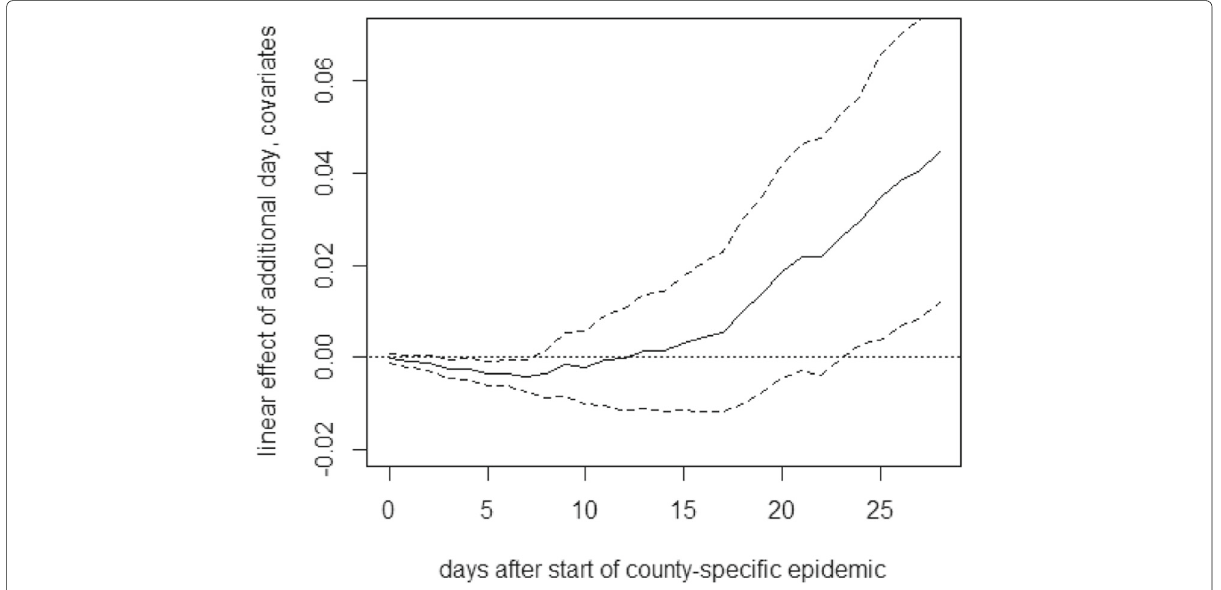
Fig. 5 OLS effect of delaying lockdown by 1 day on deaths per 10,000 inhabitants in